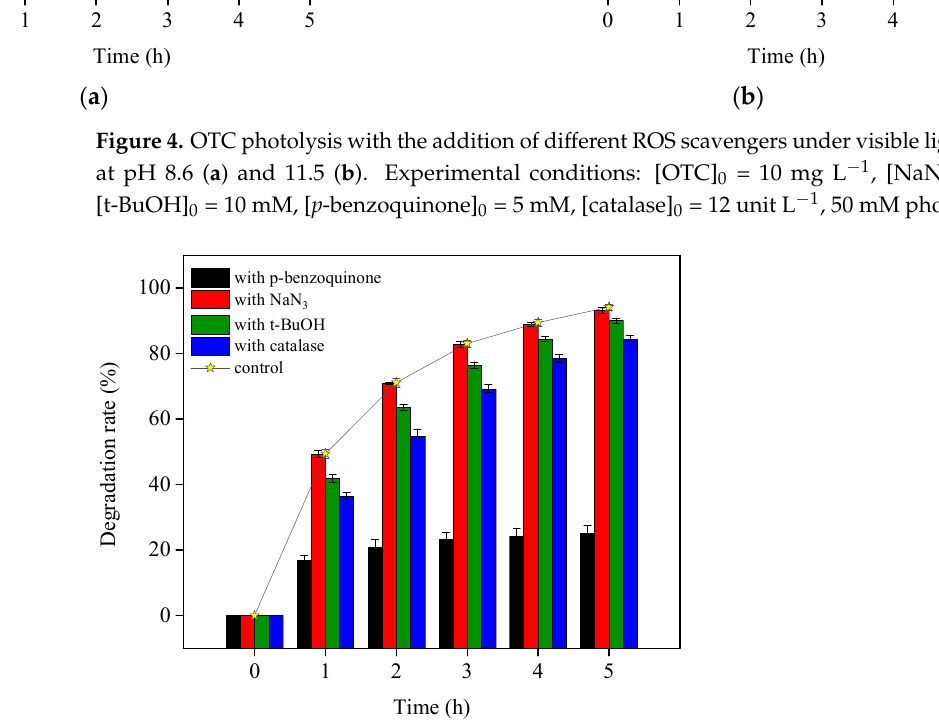
Figure 5. TiO 2 -assisted photosensitized OTC degradation with the addition of different ROS scav- engers under visible light irradiation at pH 8.6. Experimental conditions: [OTC] 0 = 10 mg L − 1 , [NaN 3 ] 0